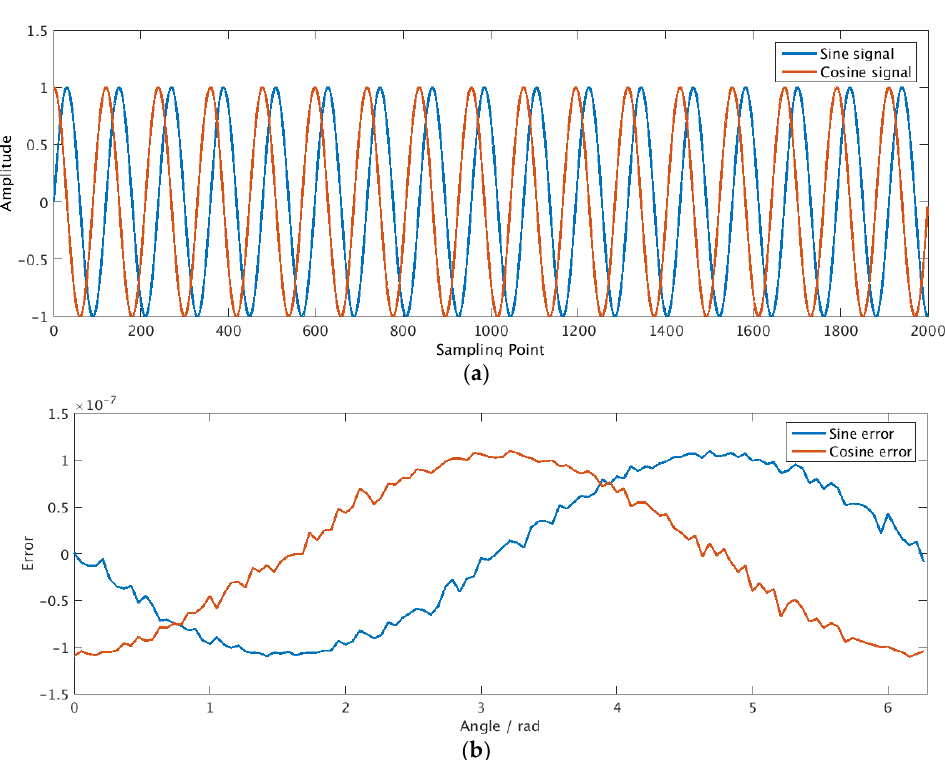
Figure 6 Digital reference signals. ( a ) Waveforms of sine and cosine signals; ( b ) error of digital reference signal. Digital simulation was performed on the data from the analog readout circuit. The simulation tool is VCS from Synopsys and the simulated input data is shown in Figure 4 in Section 3. In the simulation, (cid:2033) (cid:3030) = 10,000, (cid:2033) (cid:3046) = 100,000, φ (cid:2913)(cid:2868) = −0.2171, φ (cid:2929)(cid:2868) = 0.08, (cid:2020) = 0.03, and related parameters were quantified into fixed-point numbers and config-